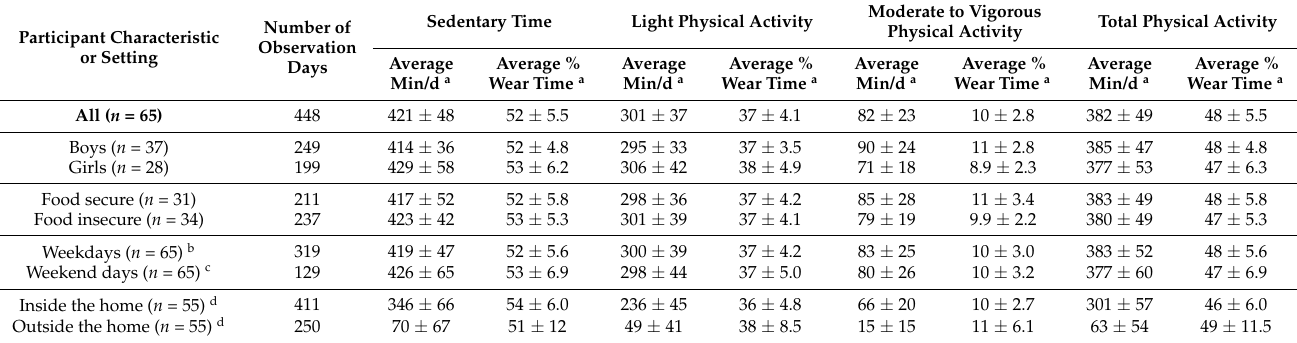
Table 2. Time and proportion of time spent sedentary and in physical activity using Trost cut-points. Participant Characteristic or